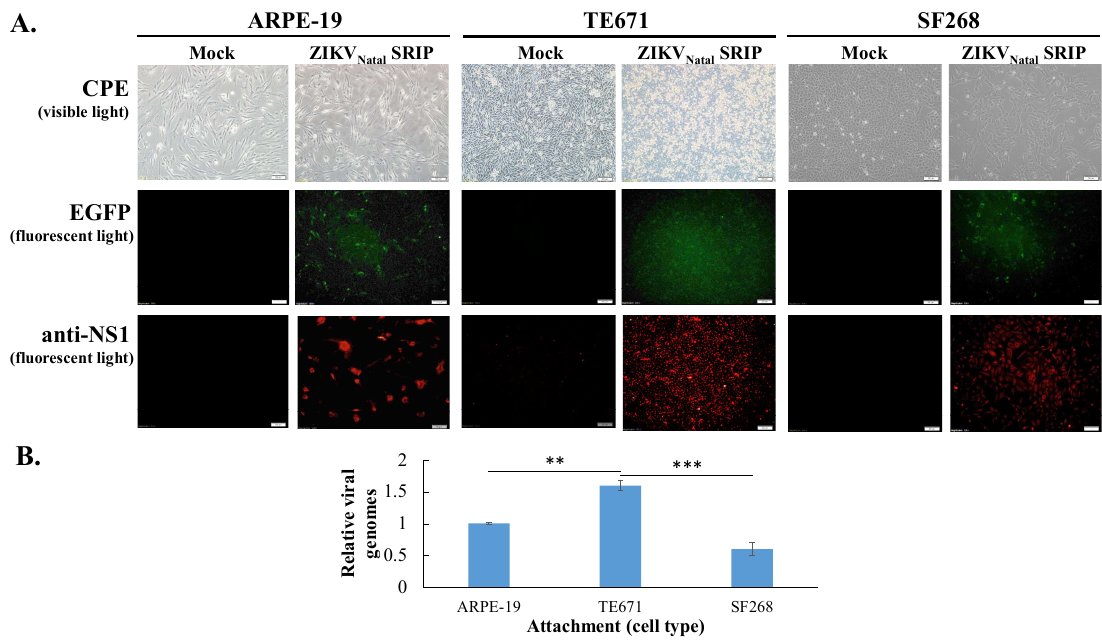
Figure 6. Cell susceptibility to ZIKV Natal RGN SRIPs. Three cell lines, ARPE-19, TE671, and SF268, were infected with SRIPs at an MOI of 0.15 TCID50/cell. The cytopathic effect (top), EGFP reporter (middle), and ZIKV NS1 protein (bottom) in SRIP-infected cells were photographed using light and fluorescence microscopy 72 h post-infection ( A ). In addition, relative viral genome levels from SRIPs attached to the surfaces of these cell lines were measured using real-time RT-PCR mRNA ( B ). **, p value < 0.01; ***, p value < 0.001 compared with mock cells. Scale bar, 100 µm.